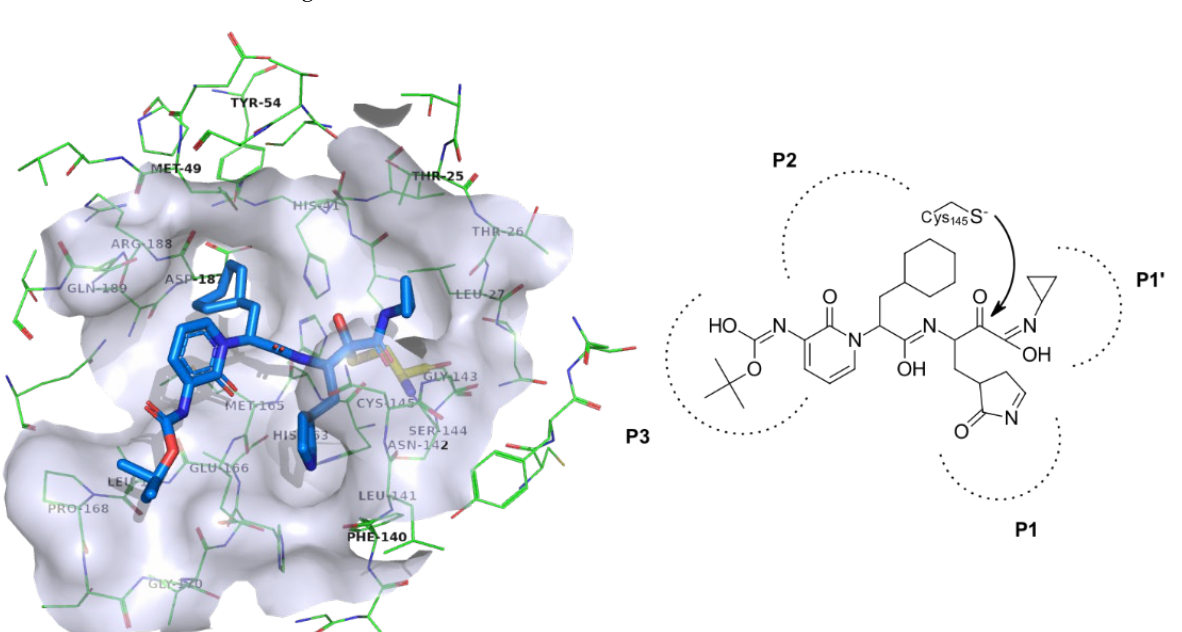
Figure 1. Active site of SARS-CoV-2 3Cl pro or M pro enzyme (PDB ID: 6Y7M) with emphasised small molecule and pocket designation on the right. Active site residues are depicted in green coloured line model with emphasized transparent blue-white surface 6 Å around the small molecule inhibitor depicted in blue coloured stick model.